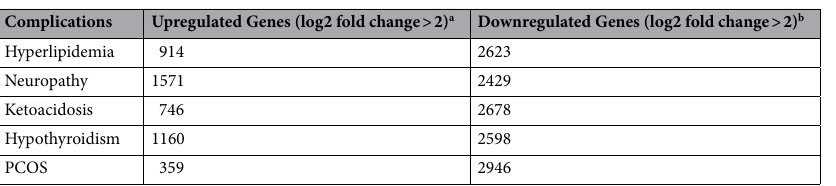
cytosol, drug catabolic process, response to purine-containing compound and peptide-serine phosphorylation (Fig. 5B). More functional pathways were associated with the common downregulated genes between DWC and ketoacidosis, and this includes G alpha signaling events, keratinization, amine ligand-binding, taste trans- duction, muscle filament sliding, hormone biosynthesis process and hair cell differentiation (Fig. 5C). Twelve functional pathways were identified in association with the common downregulated genes between DWC and